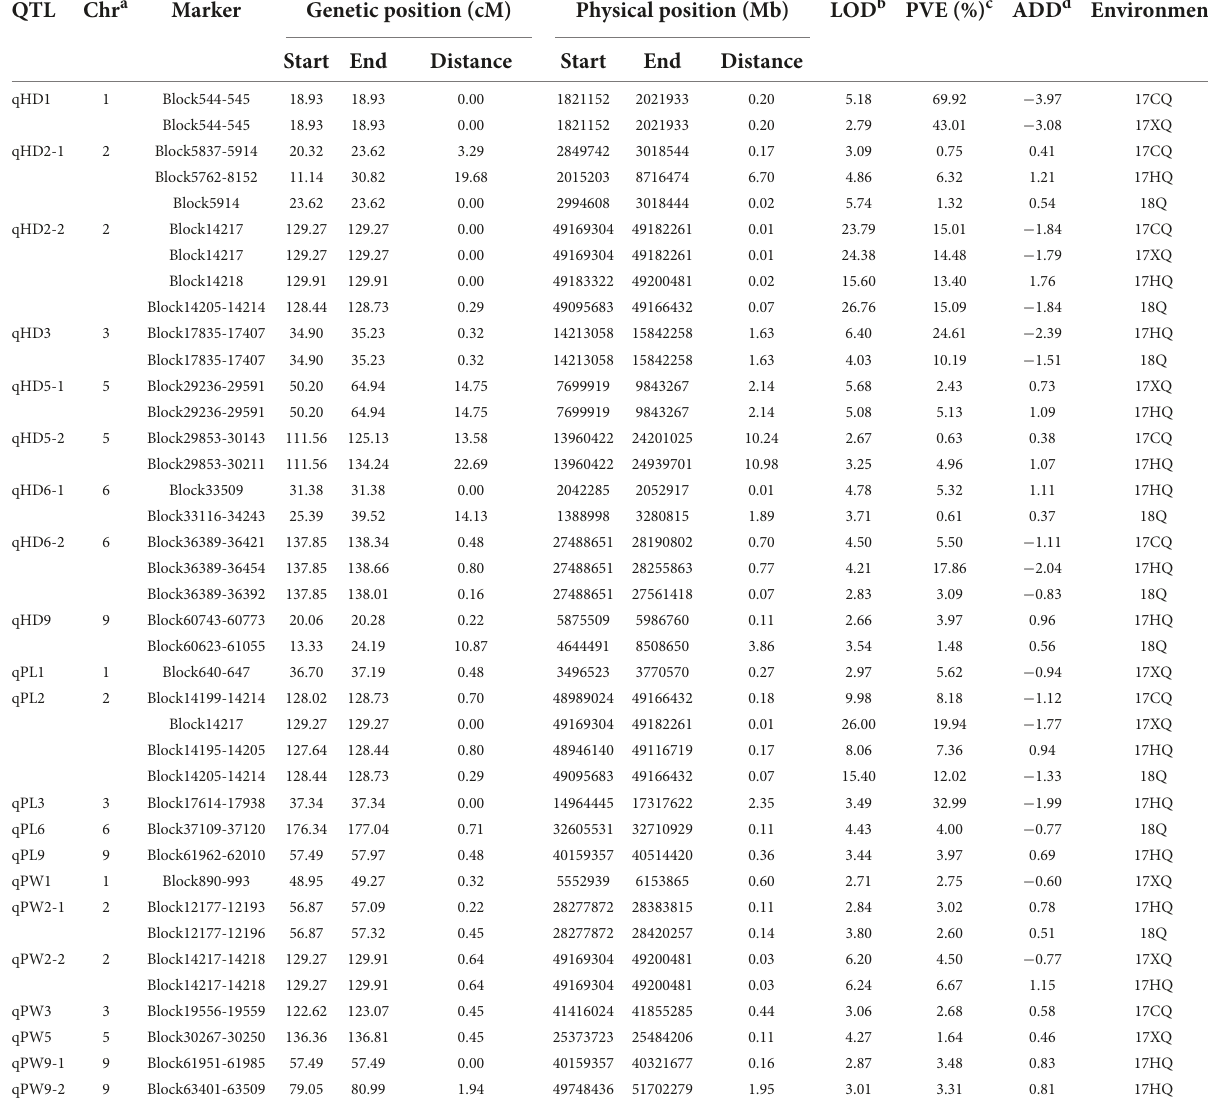
TABLE 3 Quantitative trait locus (QTL) mapping of three quality traits in the four